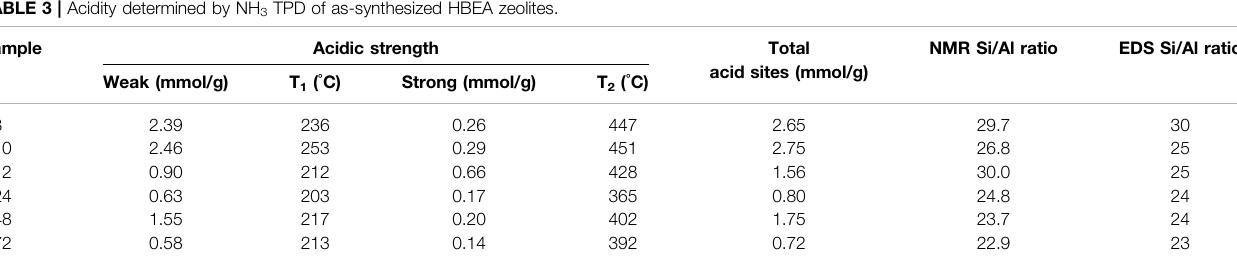
TABLE 3 | Acidity determined by NH 3 TPD of as-synthesized HBEA zeolites.